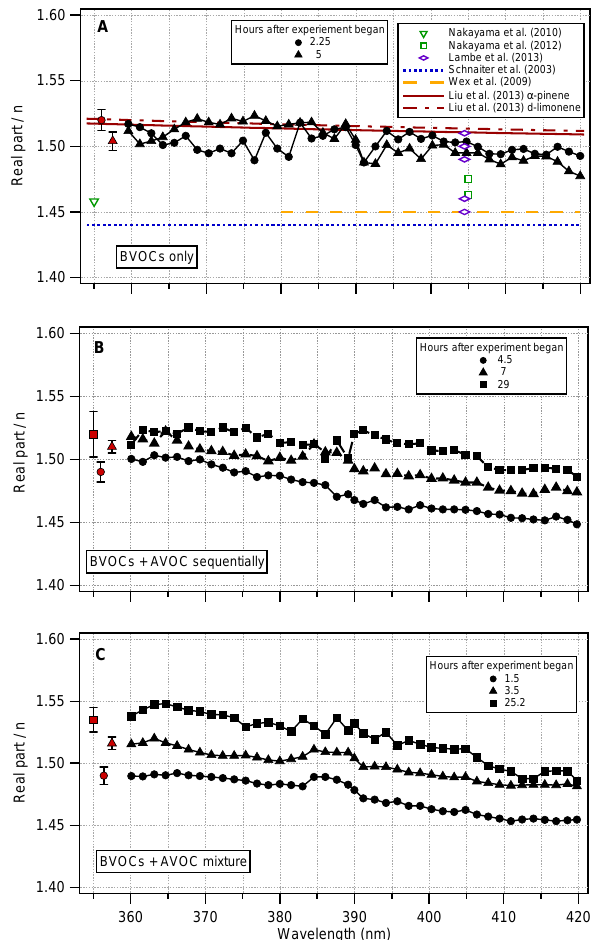
Figure 3. Change of the real part of the complex refractive index vs. wavelength as a function of time for SOA produced from (A) only a mixture of α -pinene and limonene, compared to literature values of the real RI of α -pinene; (B) a mixture of α -pinene and limonene fol- lowed by the addition of p -xylene-d 10 5h after; and (C) a mixture of α -pinene, limonene, and p -xylene-d 10 (only three retrievals are shown for clarity). The averaged error bars of the retrieved RI values are shown as red markers on the left for clarity. The average errors for the retrievals in (A) are 0.008 ( ± 0.008) and 0.006 ( ± 0.005) for 2.25 and 5h, respectively. The average errors for the retrievals in (B) are 0.005 ( ± 0.008), 0.004 ( ± 0.001), and 0.018 ( ± 0.007) for 4.5, 7, and 29h, respectively. The average errors for the retrievals in (C) are 0.007 ( ± 0.006), 0.004 ( ± 0.003), and 0.010 ( ± 0.004) for 1.5, 7, and 25.2h,